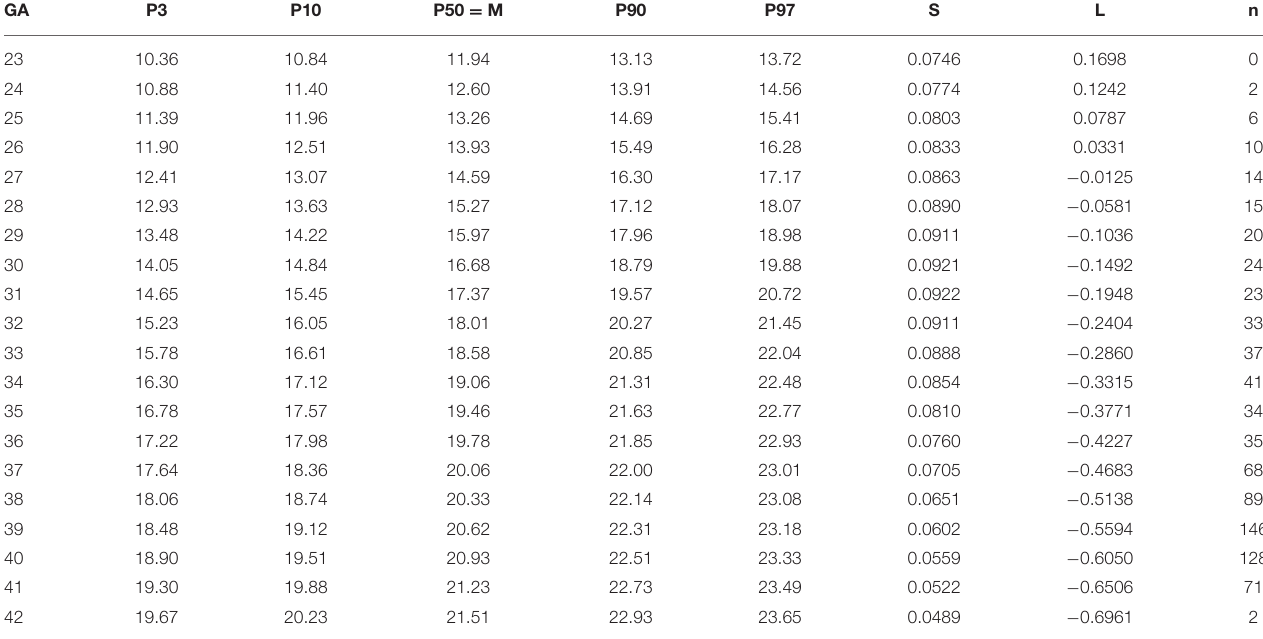
TABLE 4 | LMS parameters of models of transvertical EED (vEED) for